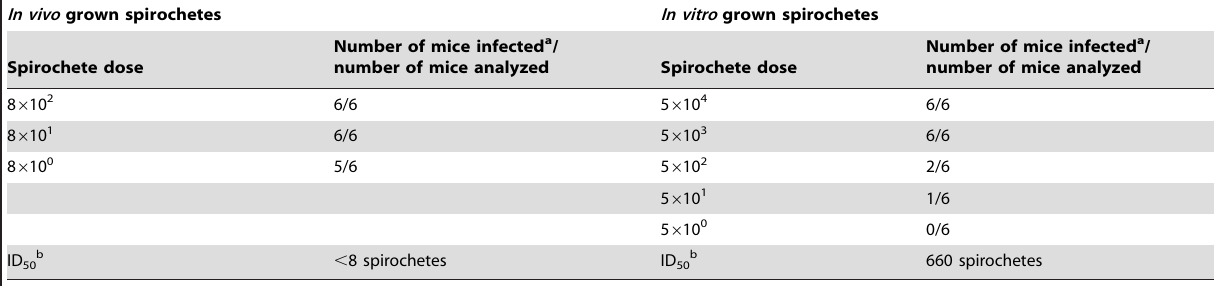
Table 1. In vivo -adapted B. burgdorferi are highly infectious.